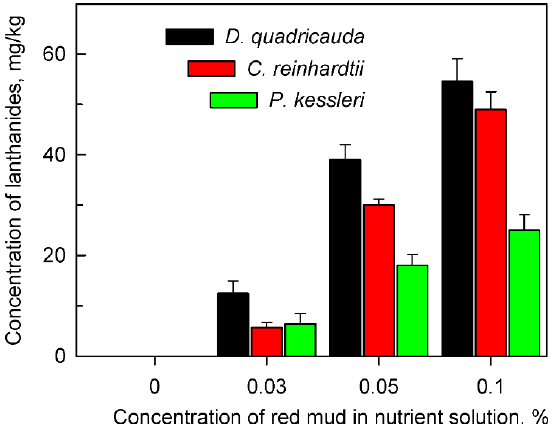
Figure 2. Total amount of lanthanides accumulated in cells of Desmodesmus quadricauda , Chlamydomonas reinhardtii and Parachlorella kessleri after 48 h of growth in the absence (0%) or presence of different concentrations (0.03, 0.05, 0.1%) of red mud in nutrient medium suitable for the given species. No lanthanides were found in cells grown in the absence of red mud.